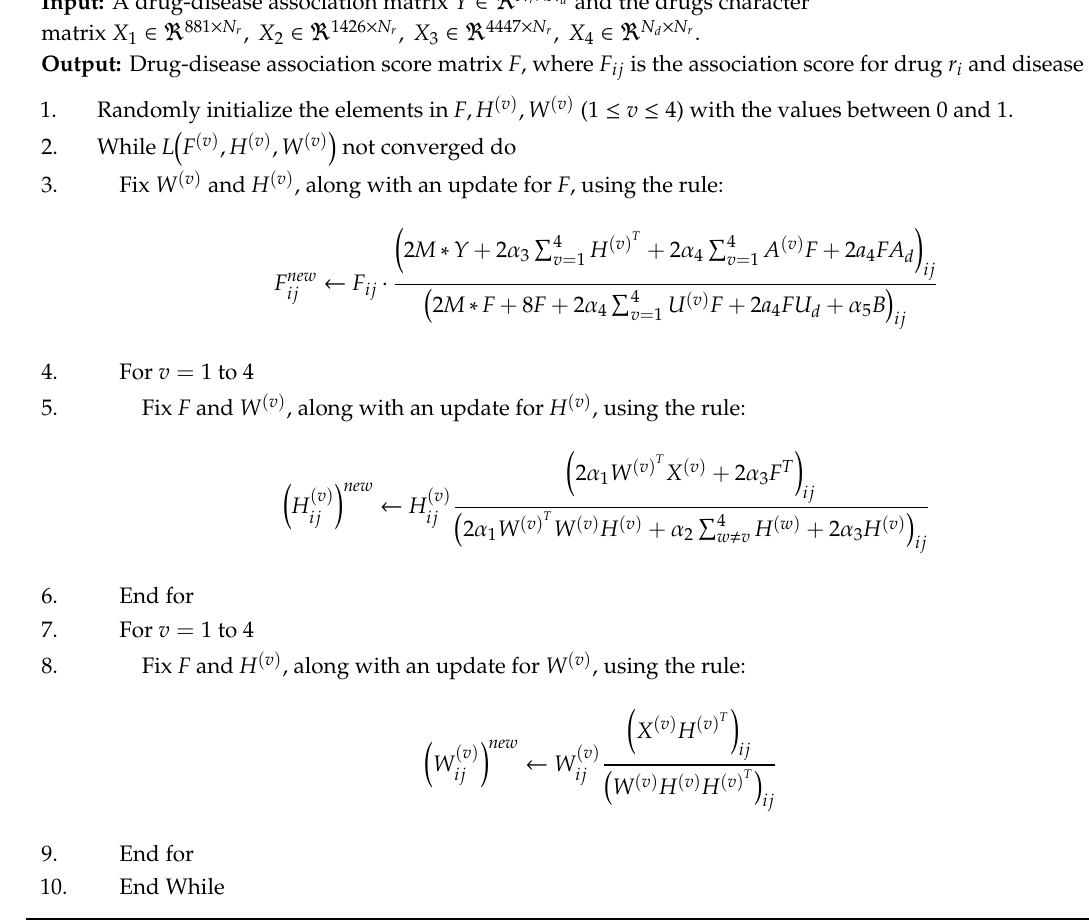
Algorithm 1 DivePred algorithm for predicting the potential drug-disease